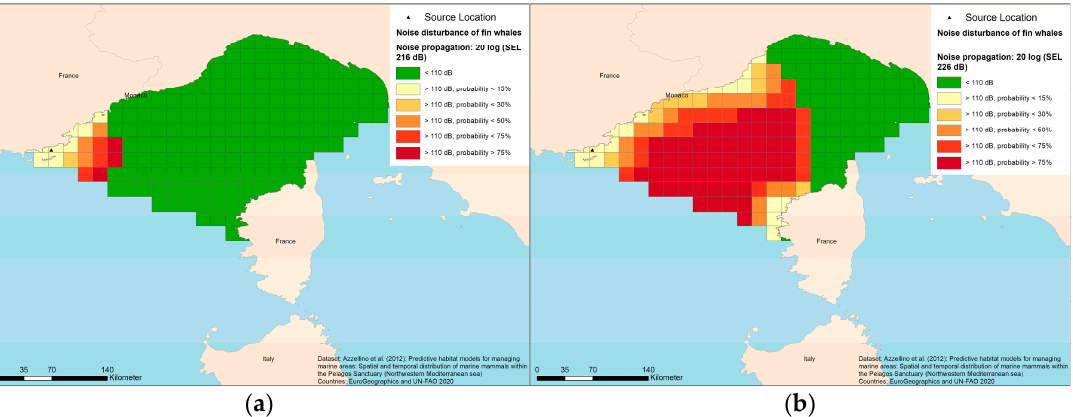
Figure 16. Potentially usable habitat probability for cetaceans exposed due to an airgun array event with an exposure threshold 110 dB, using a 20 -log law ( a ) with ESL= 216 dB re 1 µPa 2 m 2 s and ( b ) with ESL = 226 dB re 1 µPa 2 m 2 s.